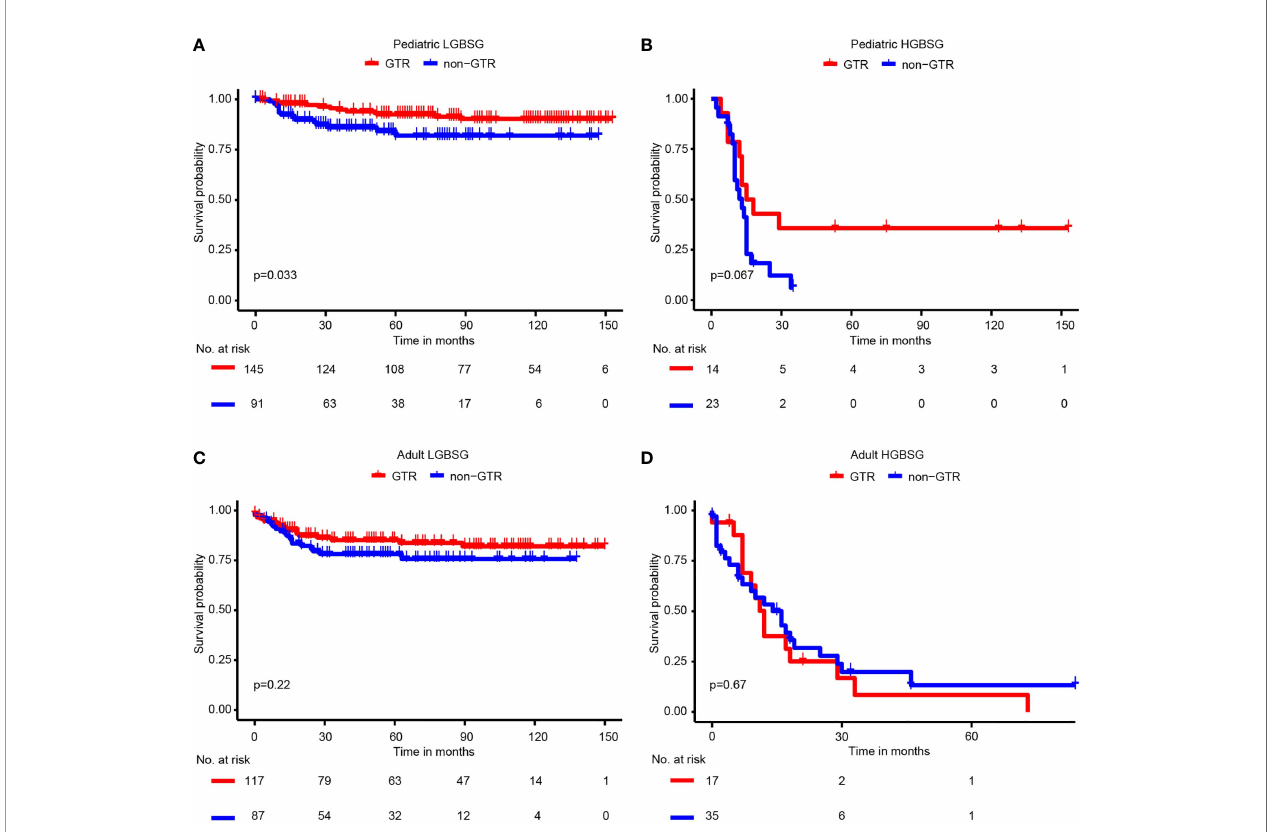
FIGURE 2 | Kaplan-Meier curves by GTR and non-GTR in different patient groups. (A) pediatric LGBGG; (B) pediatric HGBSG; (C) adult LGBSG; (D) adult HGBSG